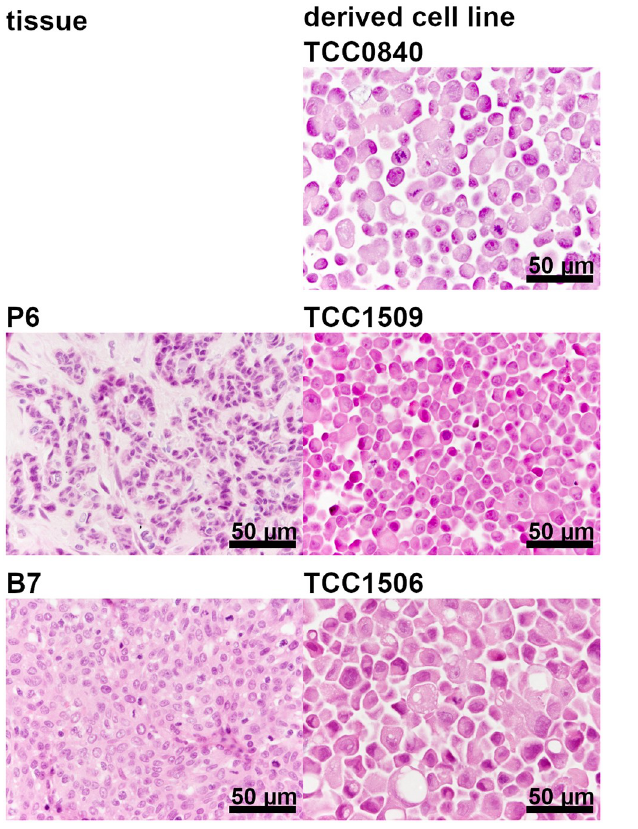
Fig 2. Formalin-fixed and HE-stained TCC tissue samples and cell